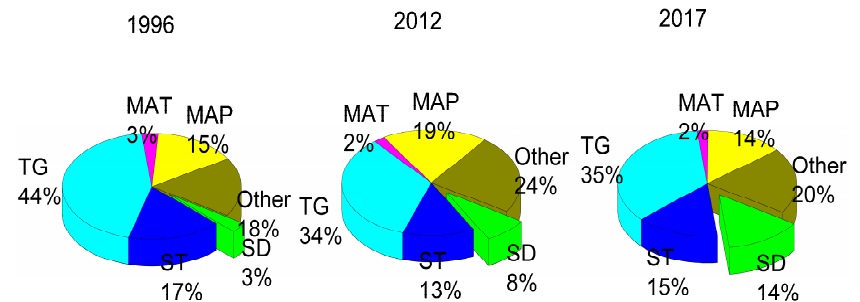
Figure 4. Influence of factors on soil available P throughout the 20-year time span, where “MAP” denotes mean annual precipitation, “MAT” represents mean annual temperature, and “TG” represents topography indicators including aspect, slope, and elevation. “ST” represents stand type, “SD” represents the stand density, and “Other” represents all the unconstrained factors.